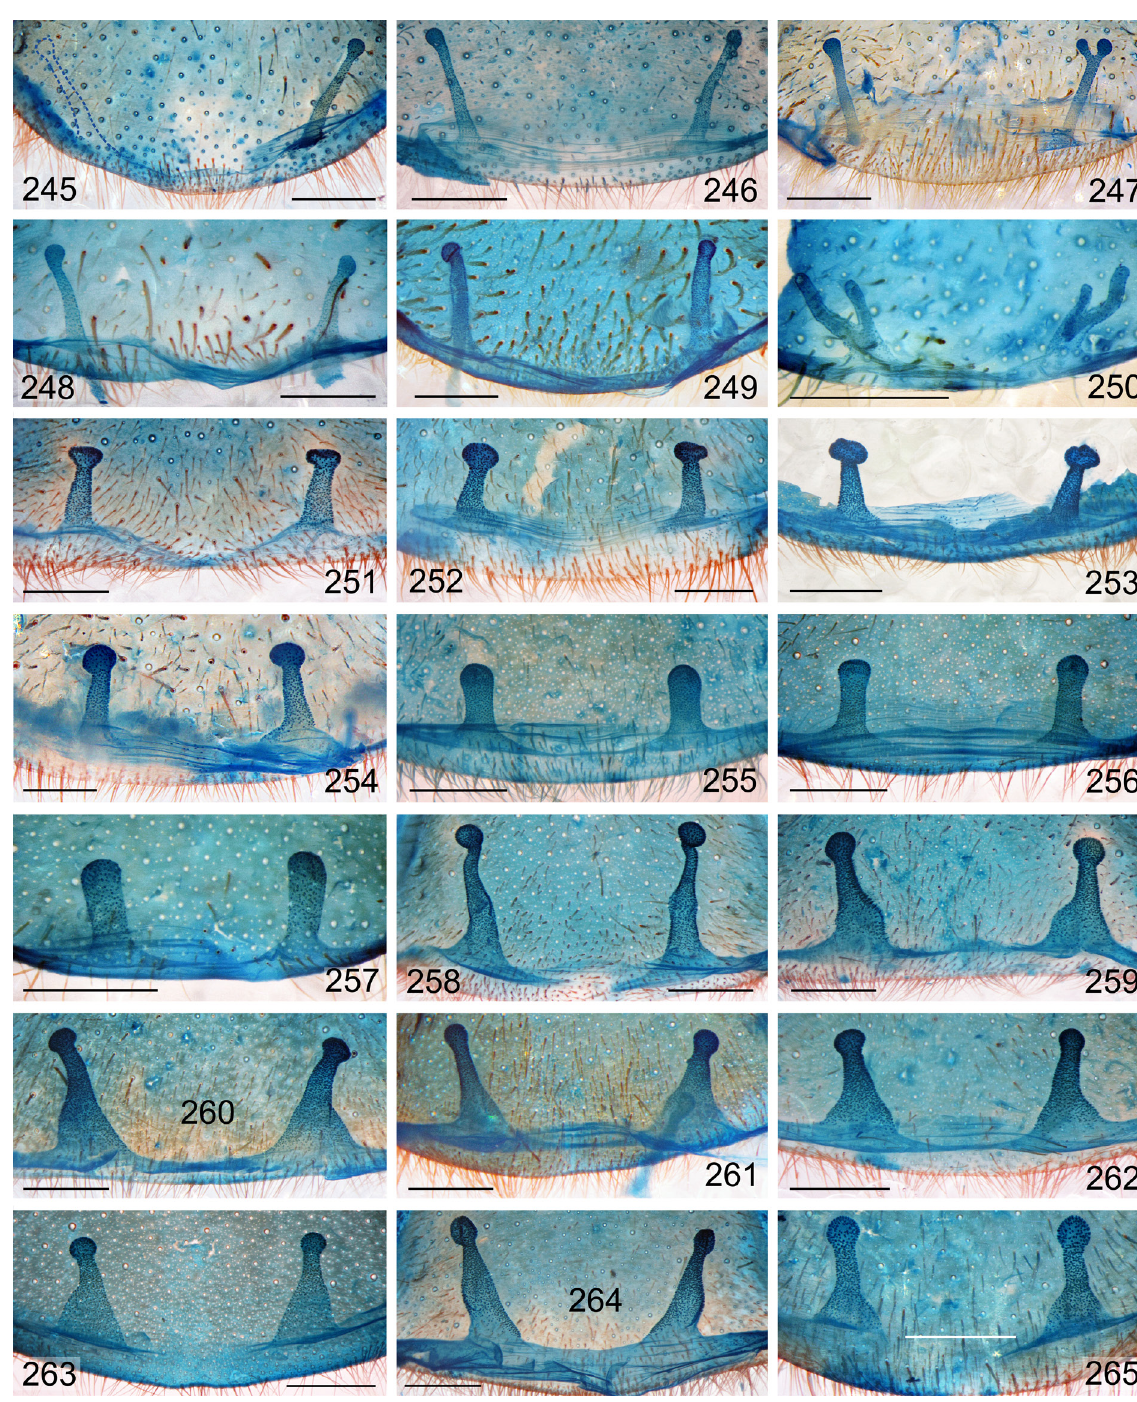
Figs 245–265. Anemesia spp., ♀♀, spermathecae, dorsal views. 245 . A. castanea sp. nov. (Ganjina).